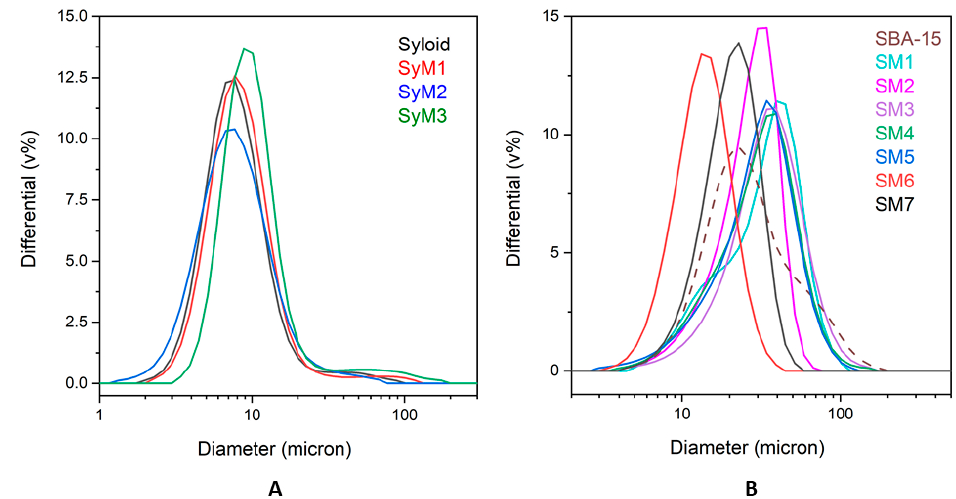
Figure 4. Size distribution of metronidazole–MSM particles (( A ): Syloid, ( B ): SBA-15).